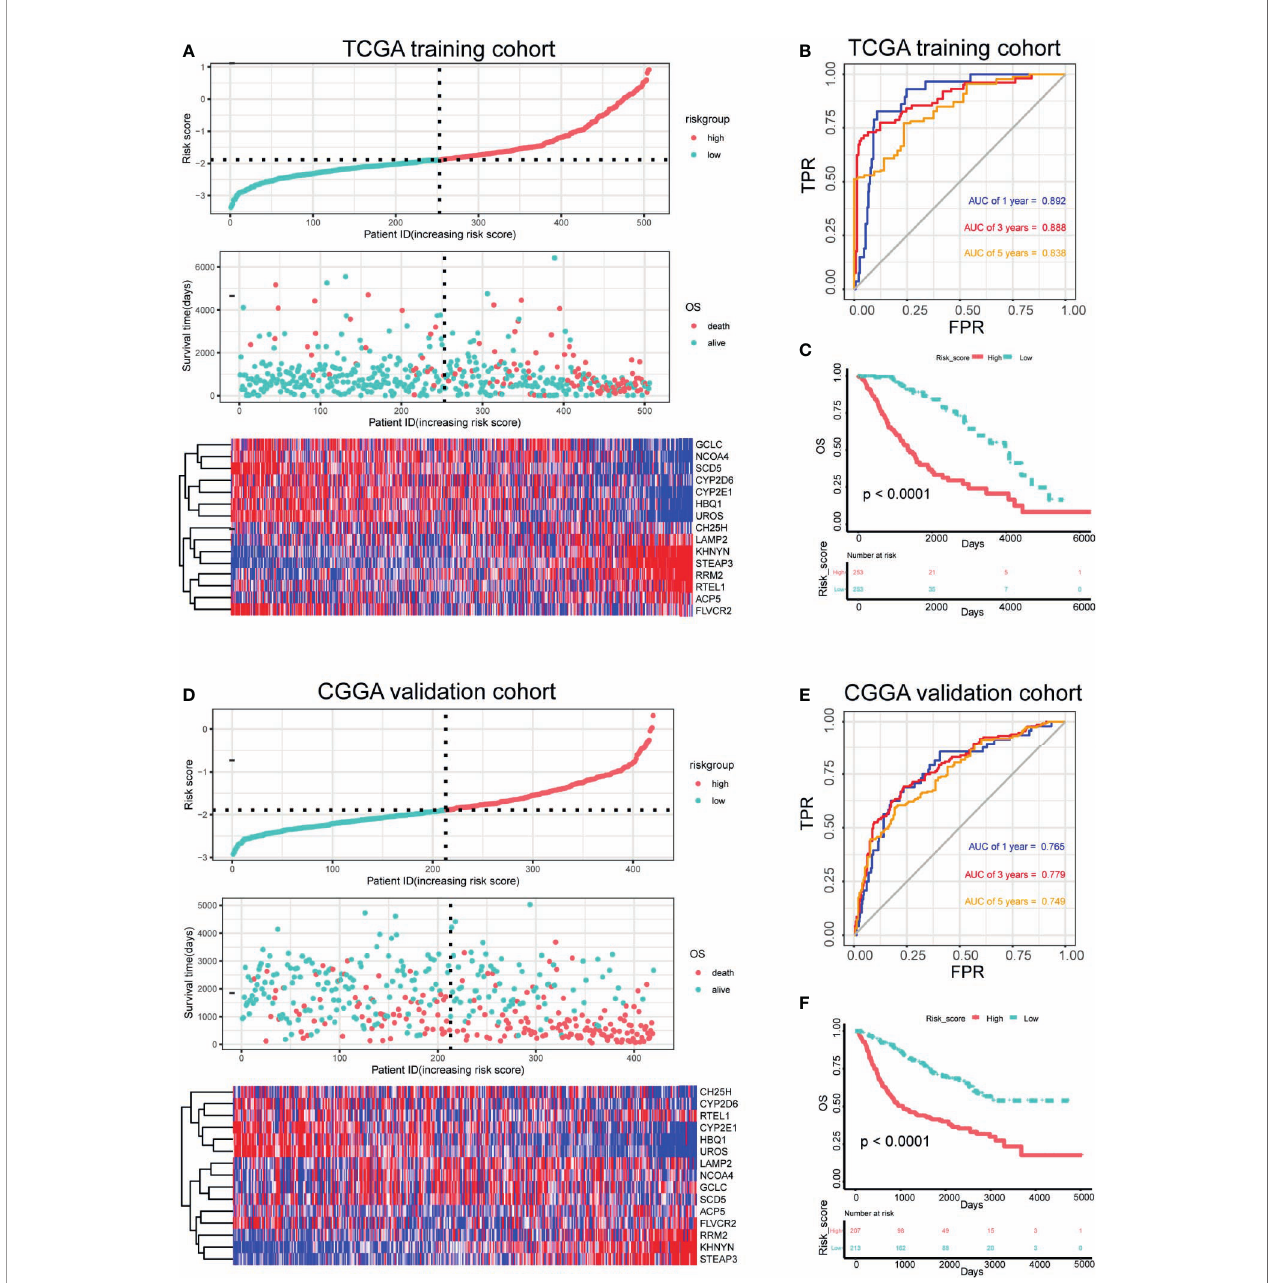
FIGURE 4 | Risk score analysis, survival analysis and prognostic performance of a risk-score model based on differential expression of iron metabolism-related genes in patients with LGG. Risk score and survival time distributions, and heatmaps of gene-expression levels of the iron-metabolism signature in the TCGA (A) and CGGA (D) cohorts. ROC curves and AUC values of the risk score model for predicting the 1-, 3-, and 5-year OS times in the TCGA (B) and CGGA (E) cohorts. Kaplan – Meier survival analysis was performed to estimate the OS times between the high- and low-risk groups in the TCGA (C) and CGGA (F)